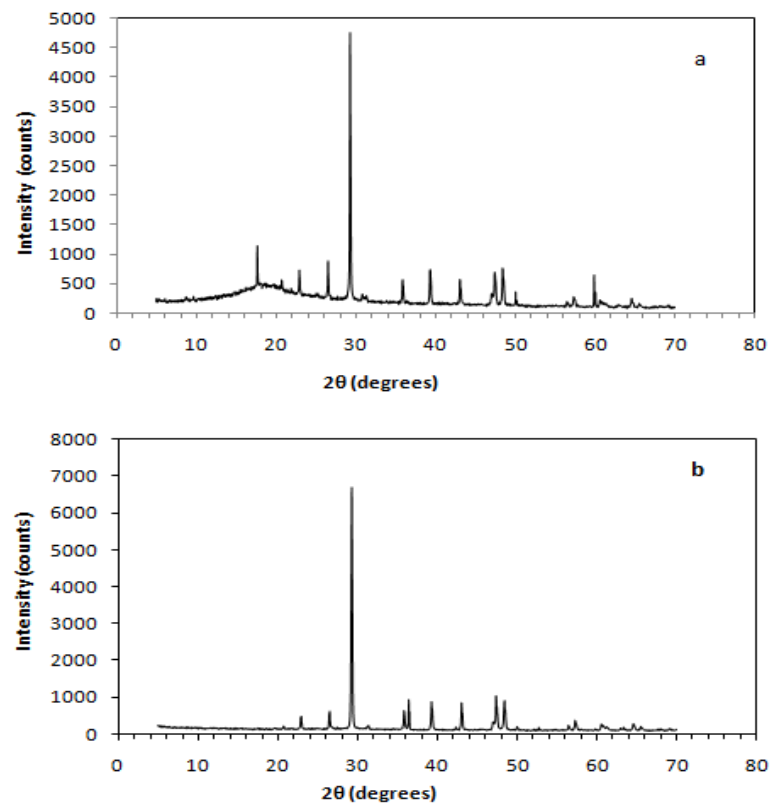
Figure 10. X-ray diffractograms of novolac resin matrix composites ( a ) 300 μ m composites and ( b ) 500 μ m composites.